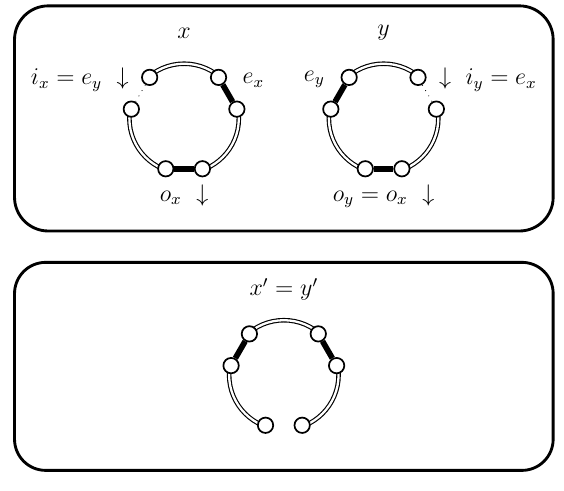
Figure 11. In this case the distance of the coupled states increases, i.e., d ( x (cid:48) , y (cid:48) ) = 2. Therefore we include a new state z (cid:48) in between x (cid:48) and y (cid:48) and define e z